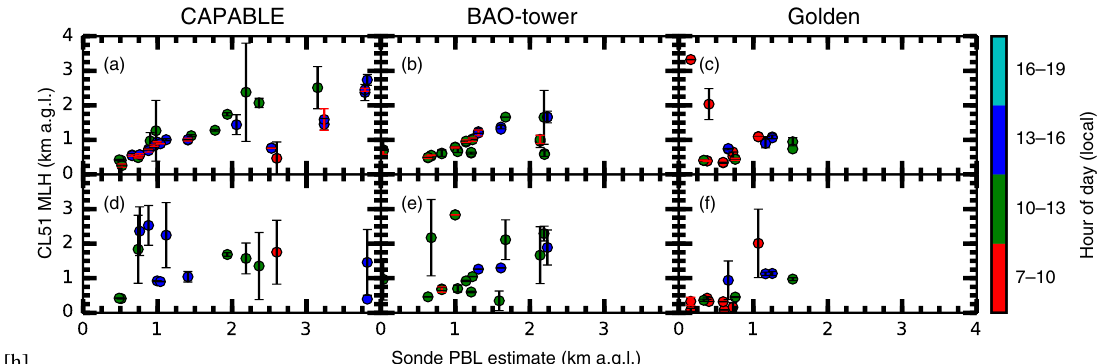
Figure 9. Correlation plots for CL51 MLH and sonde-derived ABL estimates. Black error bars represent the spread in unfiltered data, while the red error bars represent the filtered data set. MLH values (30min average, centered on sonde-launch time) were calculated in BLView (panels A–C) and STRAT (panels D–F) and resampled to 30min resolution. Error bars indicate SD of the CL51-derived MLH within the 30min period.